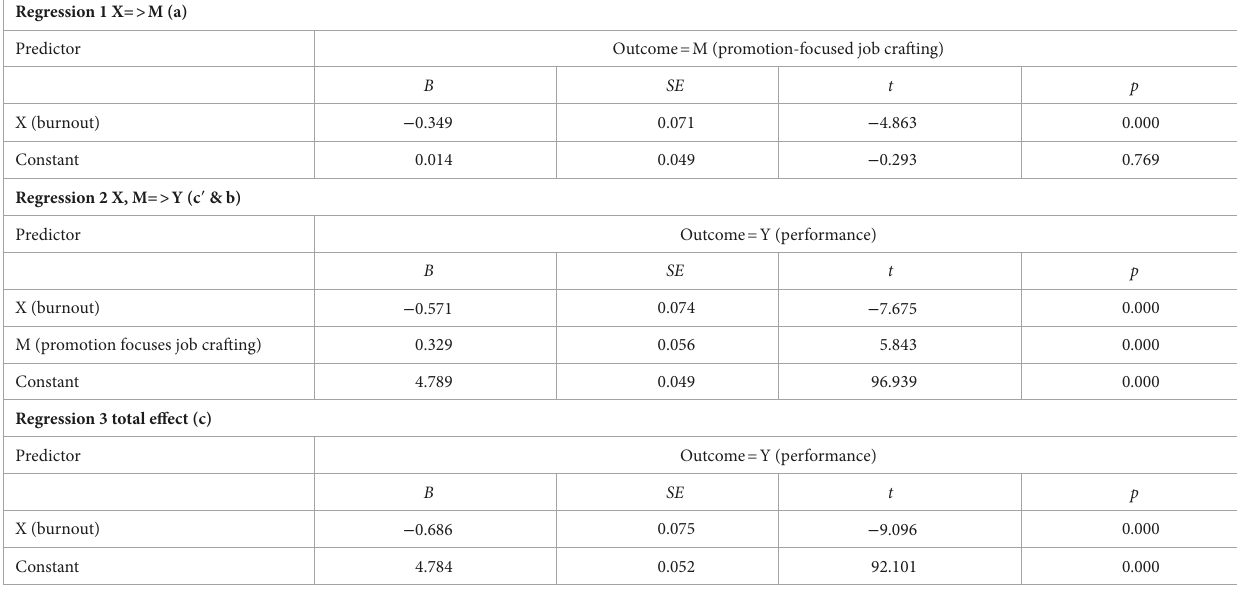
TABLE 5 Analysis of promotion-focuses job crafting mediation on the influence of burnout on performance (simple mediation model for promotion- focuses job crafting). Regression 1 X= > M